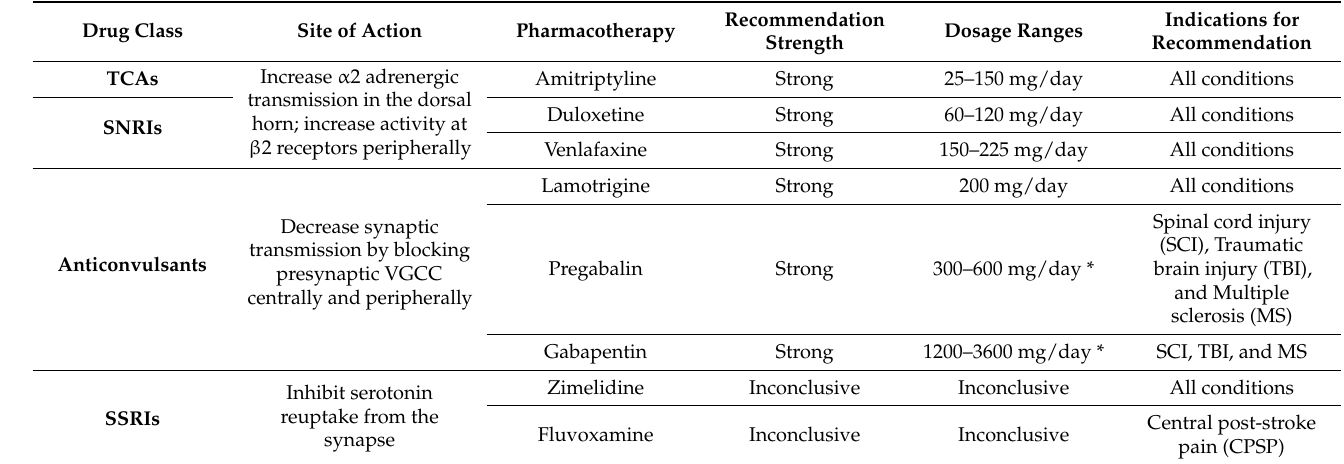
Table 1. Guideline of Pharmacotherapy Recommendations. Summary regarding pharmacologic recommendations for the treatment of centralized pain